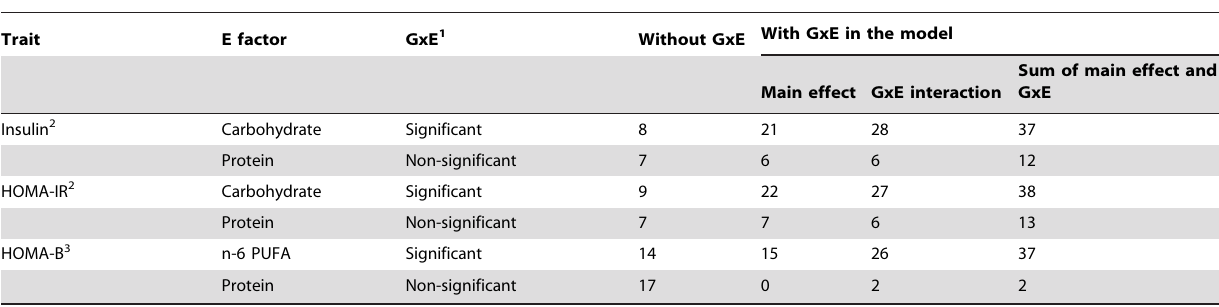
Table 3. Number of SNPs with nominal P -value # 10E-5 based on GxE GWAS.